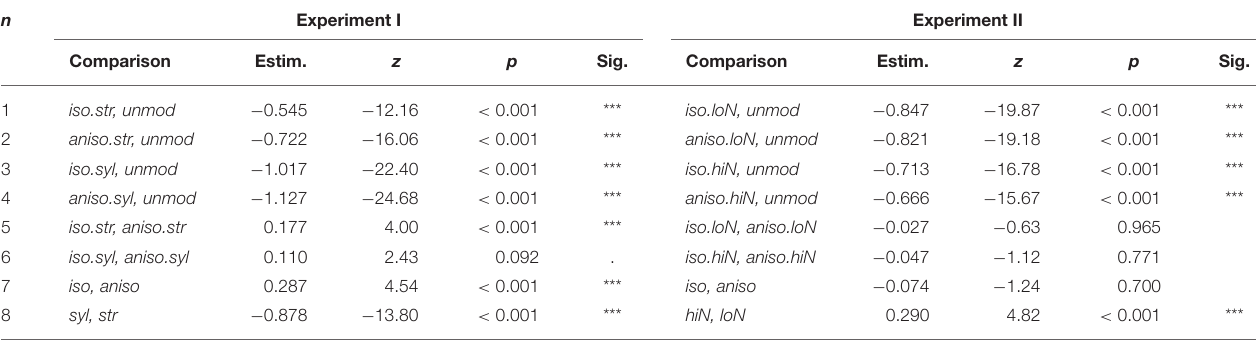
TABLE 1 | Output of generalized linear mixed models fitted separately for each experiment. n Experiment I Experiment II Comparison Estim. z p Sig. Comparison Estim. z p Sig.